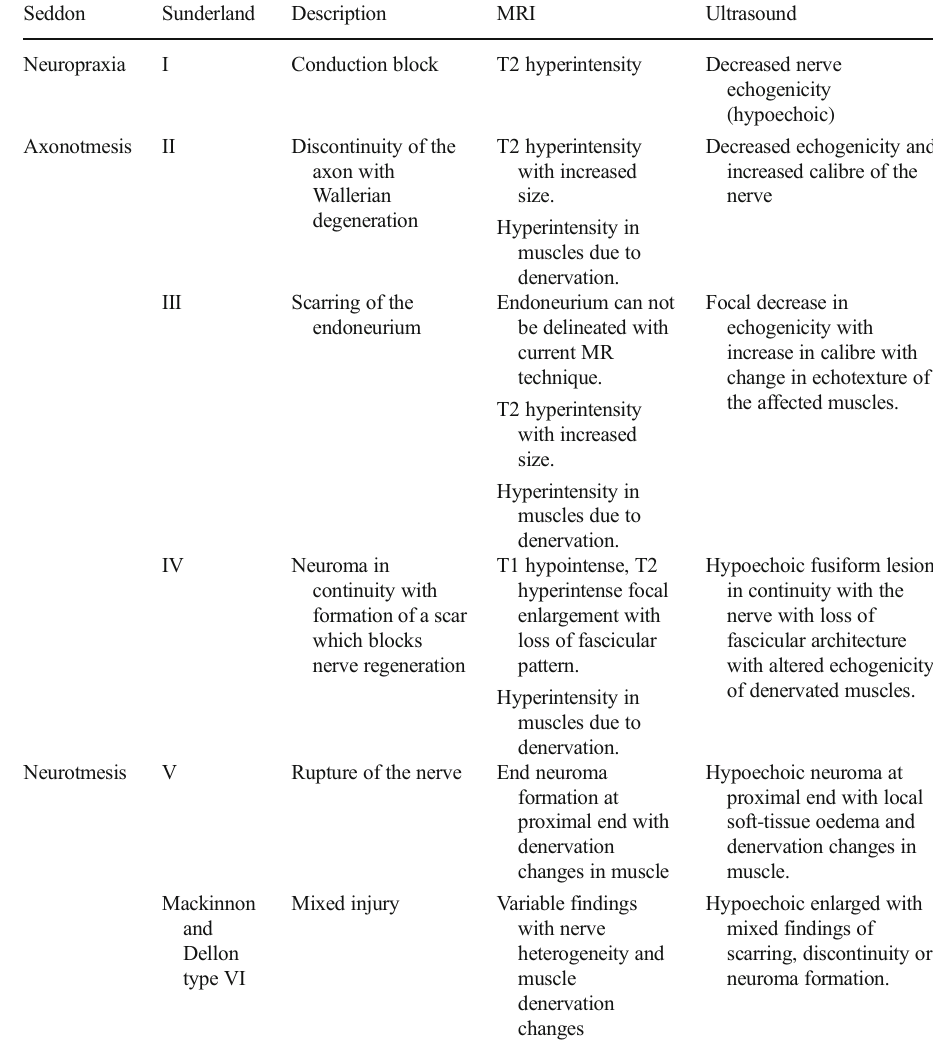
Table 1 Co-relation between Seddon ’ s & Sunderland ’ s classification of nerve injury with imaging